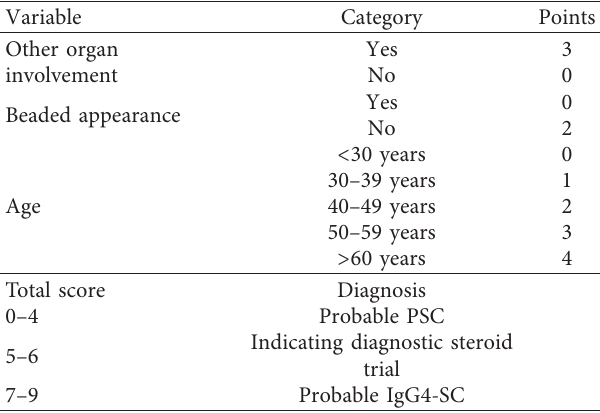
Table 3: Scoring system for the differentiation of IgG4-SC and PSC